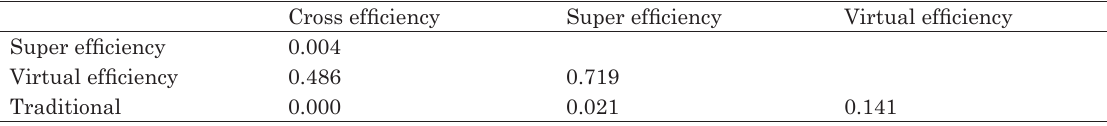
Table A.1. Pearson correlation statistics of ranking